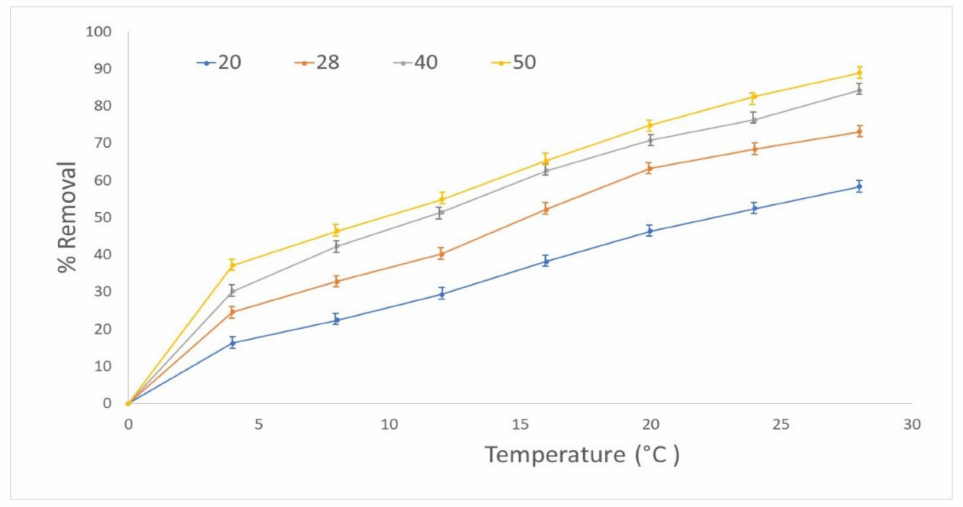
Figure 3. Effect of temperature on the removal of cobalt (II) by E. crassipes . 100 mg/L cobalt (II). pH 5.0. 100 rpm. 1 g of natural biomass. 28 h of